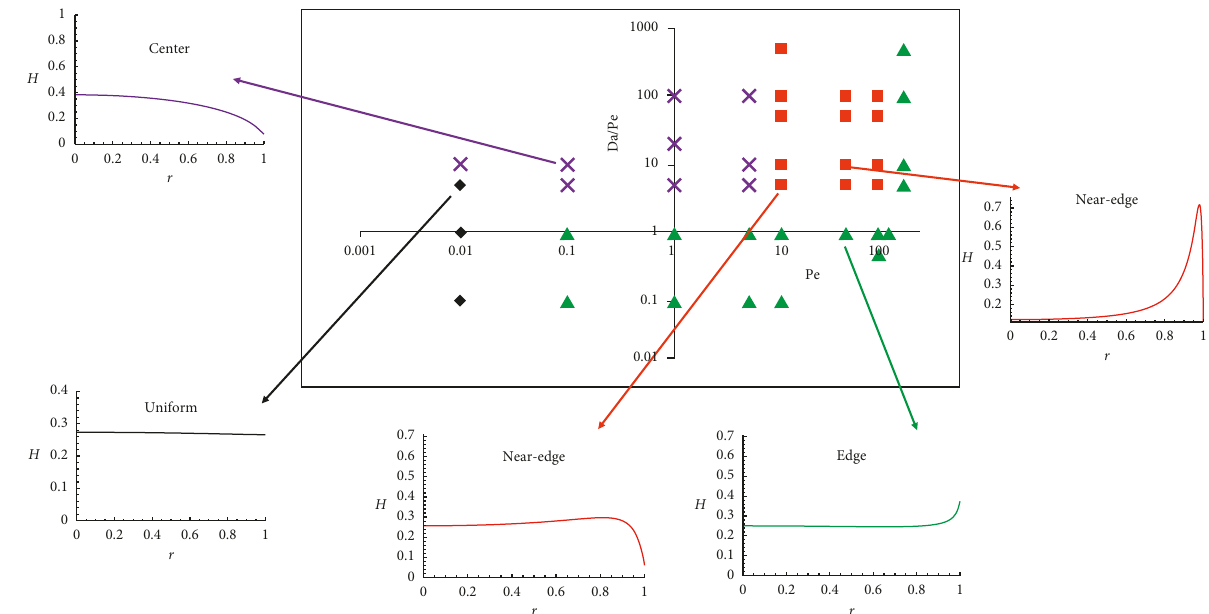
Figure 8: Phase diagram for the deposition under different Da/Pe and Pe numbers. Initial AR � 0.5, H �